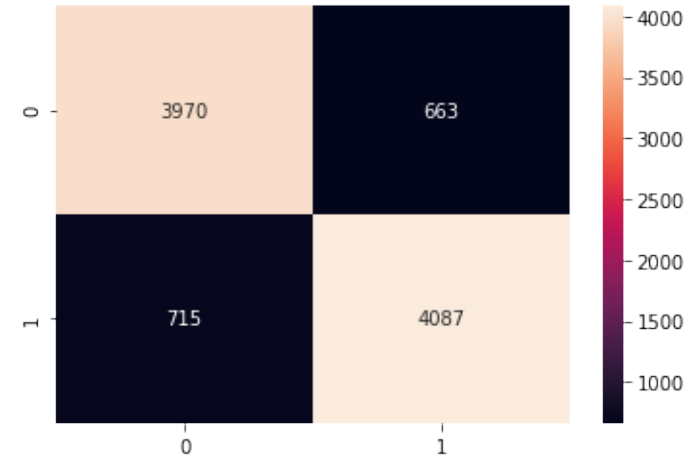
Figure 15. Naive Bayes confusion matrix.